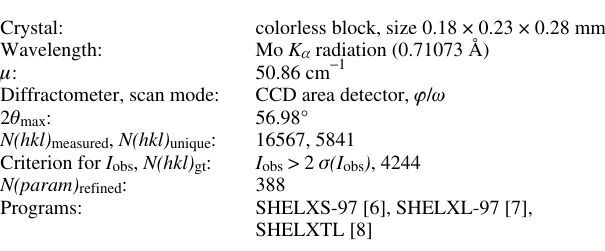
Table 1. Data collection and